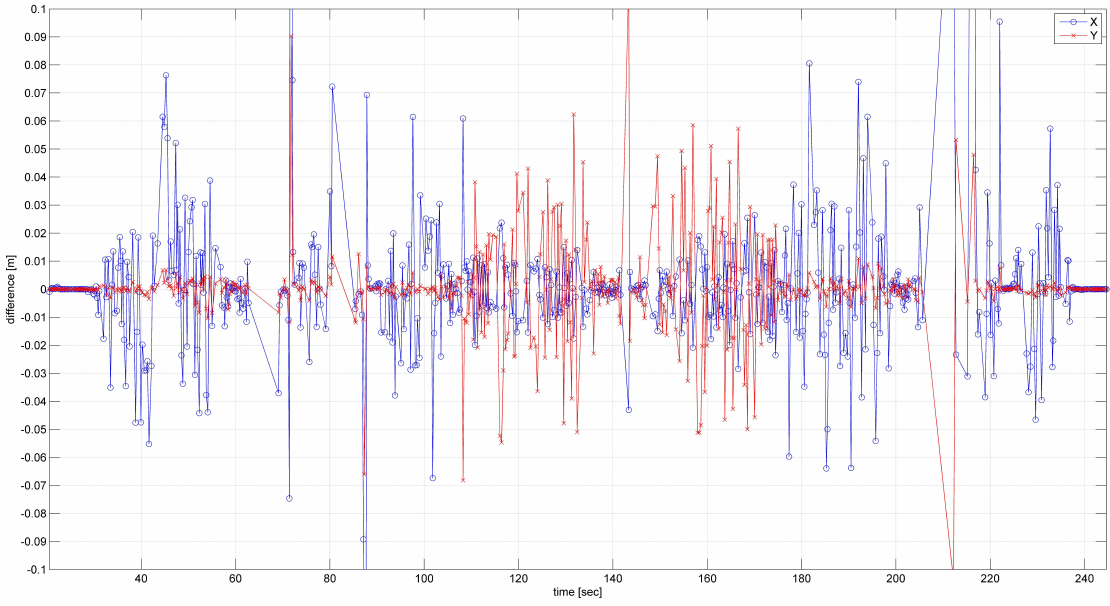
Figure 12. Coordinate differences between total station control points and the Kalman filter from trajectory 2. The variations in X and Y are presented in red and blue, respectively. It is striking that the differences are greater in the track